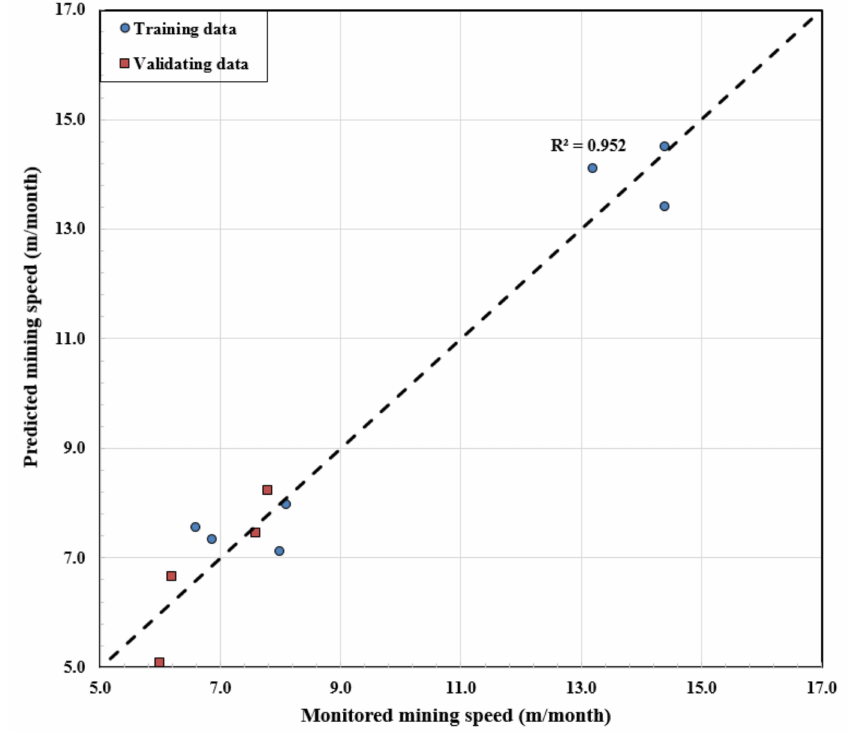
Figure 14. Comparison of the predicted mining speed and the measured mining speed using the proposed